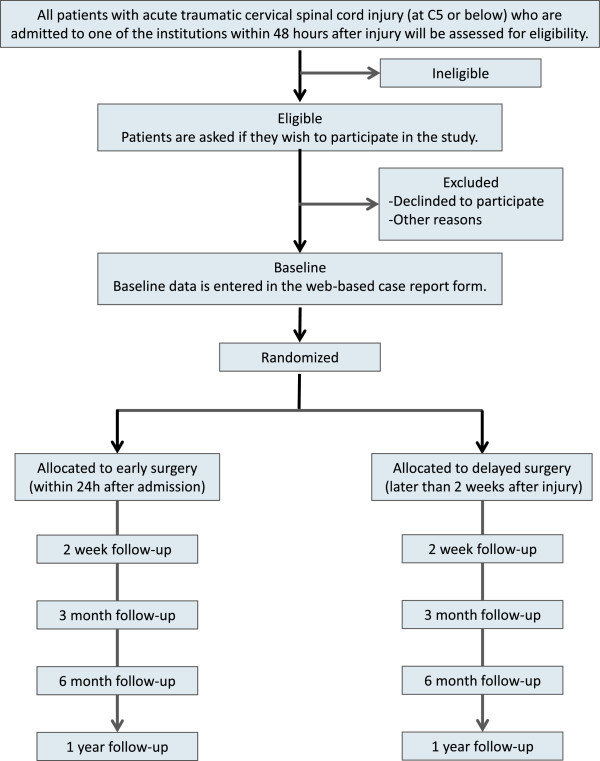
Study flowchart.